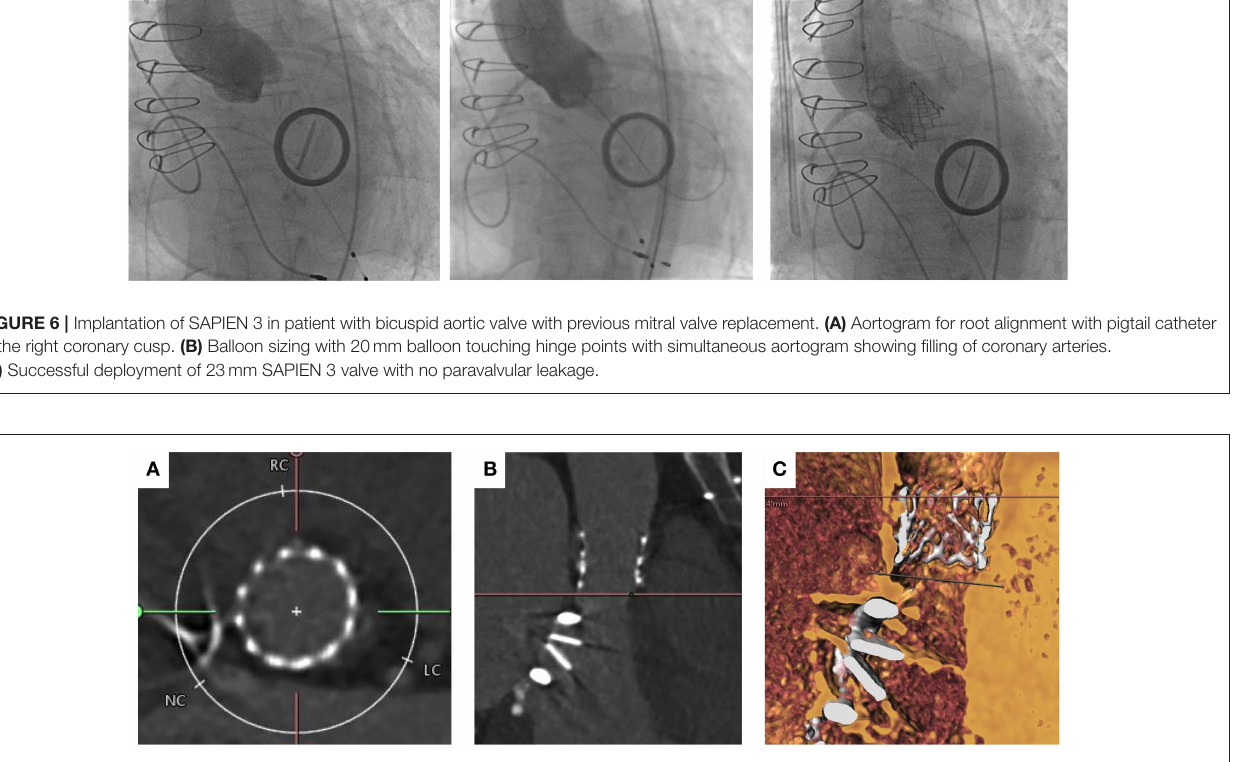
FIGURE 7 | MSCT imaging of the aortic annulus post TAVI implantation with 23mm Edwards Sapien Valve. (A) shows circular deployment of the transcatheter heart valve. (B) Left ventricular outflow tract view showing bi-leaflet mitral valve prosthesis and TAVI valve post deployment. (C) Volume rendered imaging confirming there is no interaction between the base of the TAVI valve and mitral valve